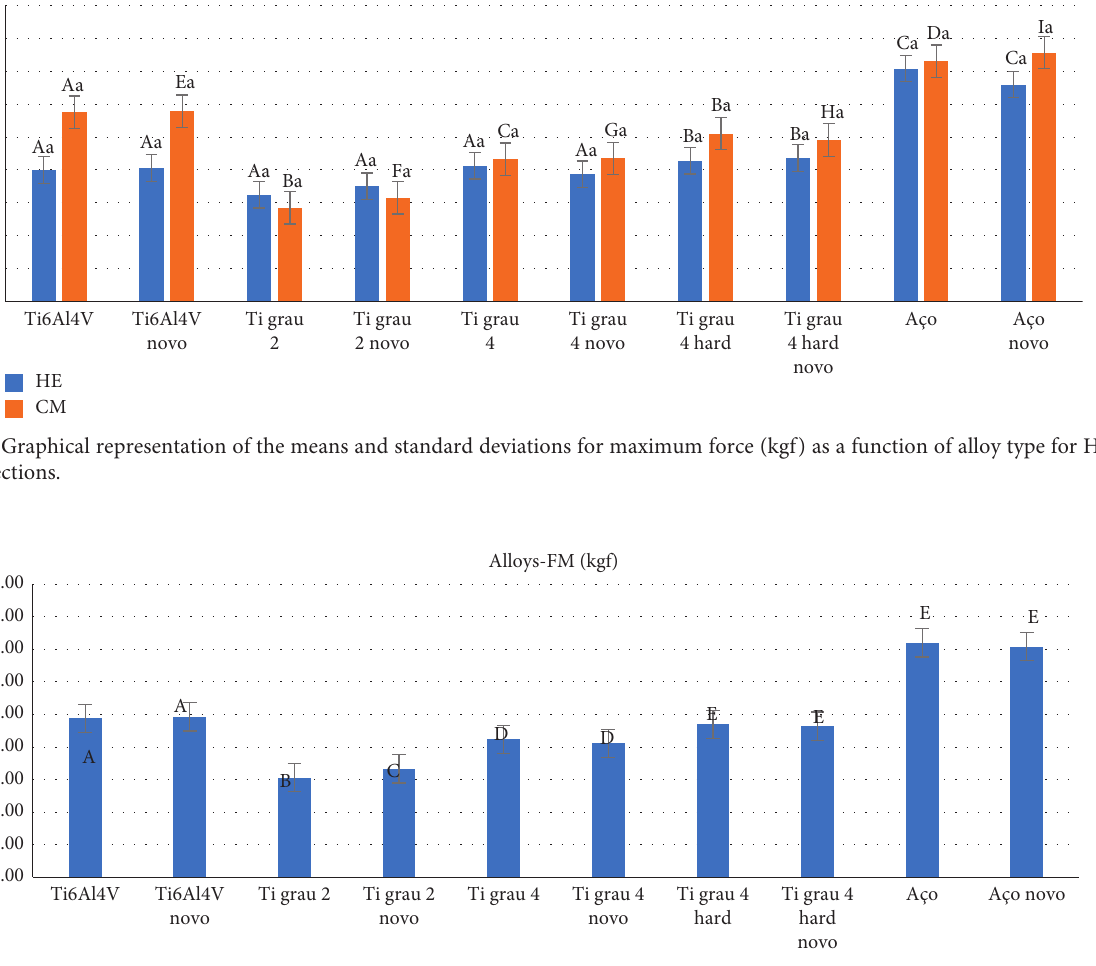
Figure 10: Graphical representation of the means and standard deviations for maximum force (kgf) as a function of the type of metal alloy and its aging (new and cycled), independent of the type of